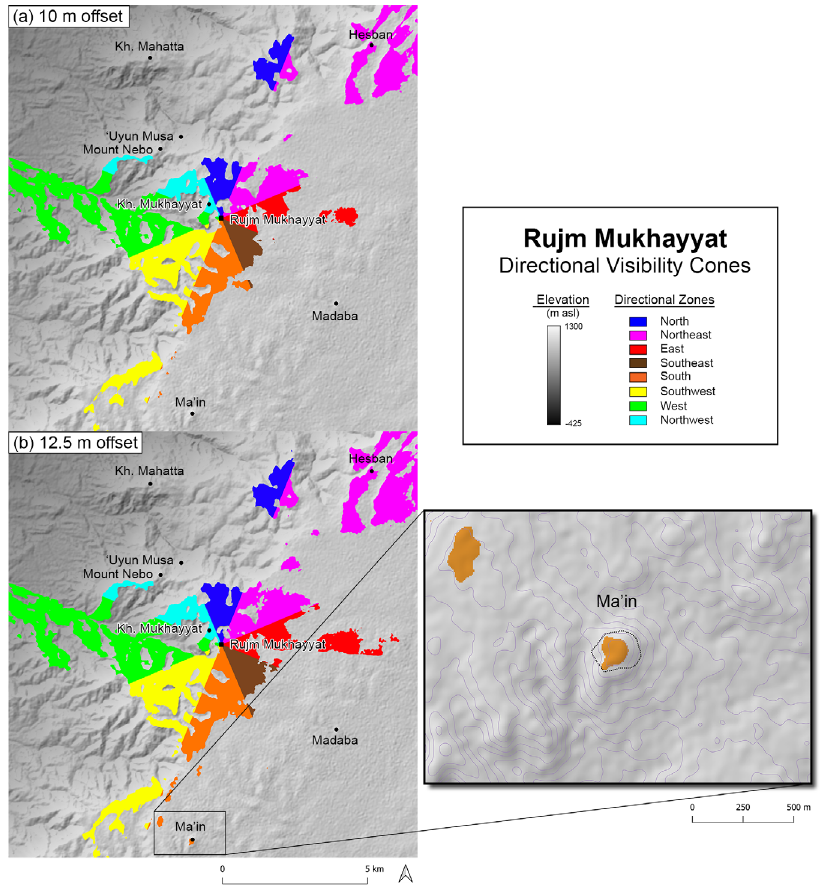
Figure 10: Map showing the directional visibility cones as measured from Rujm al-Mukhayyat using observer/target offsets of (a) 10 m and (b) 12.5 m. Panels show only a detail of the central region of the viewshed. For the full extent of the viewshed at the maximum observer/target offset, see Fig. 7(b). The inset at the bottom right shows a detail view of Ma’in, which is just visible from Rujm Mukhayyat at an observer/target offset of 12.5